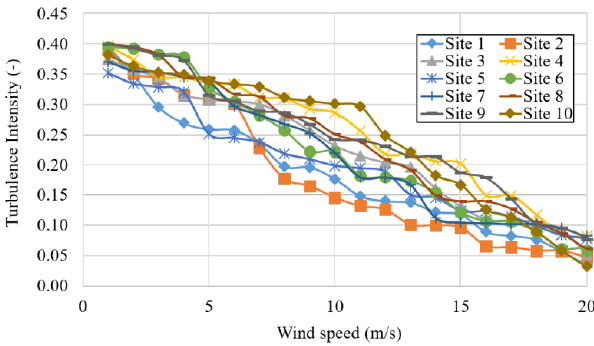
Figure 9. Estimation of TI at newly proposed wind farm sites (90 m height) .